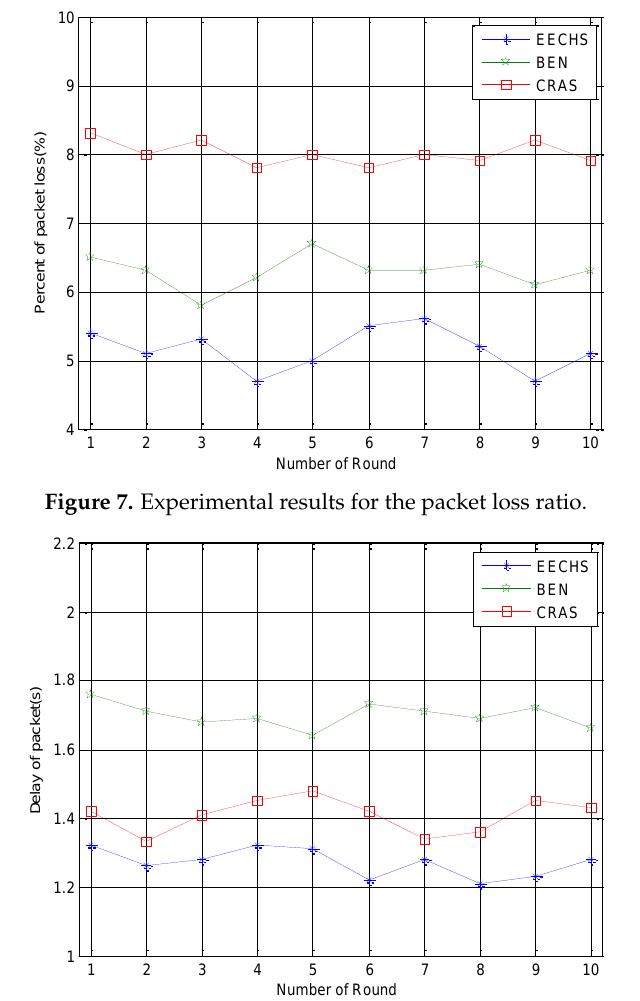
Figure 8. Experimental results for average packet delivery